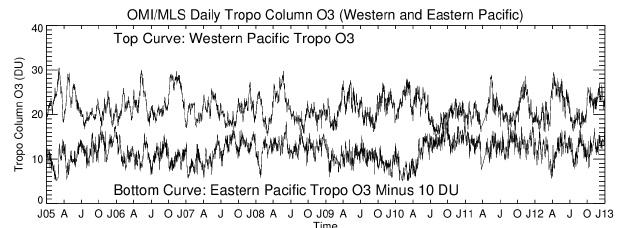
Figure A1. Top curve is daily tropospheric column ozone in Dob- son units from OMI/MLS averaged over the western Pacific (15 ◦ S– 15 ◦ N, 70–140 ◦ E). Bottom curve is daily tropospheric column ozone in Dobson units from OMI/MLS averaged over the eastern Pacific (15 ◦ S–15 ◦ N, 110–180 ◦ W). The bottom curve for eastern Pacific ozone was displaced by − 10DU for plotting.